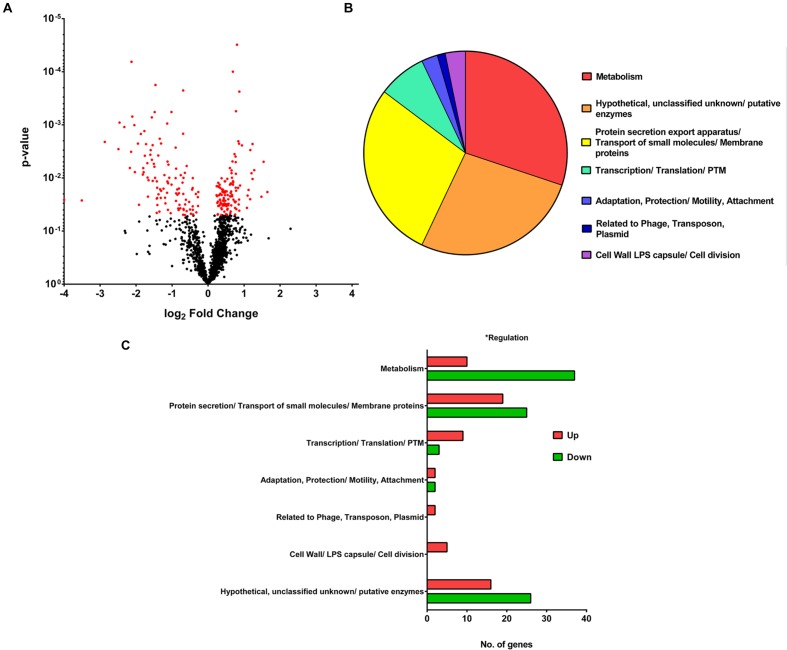
Microarray analysis.
(A) Volcano Plot showing the fold change and p-value of the 1566 probesets. For a gene to be differentially expressed, it must satisfy the criteria of p-value <0.05 and fold change > 1.5 or < -1.5. One hundred and forty-eight differentially expressed genes (DEGs) are shown in red on the plot. (B) Pie chart showing PseudoCAP functional classification of DEGs, with metabolism, hypothetical proteins and protein secretion forming the majority. (C) Bar graph showing PseudoCAP functional classification of DEGs sorted according to their expression level.